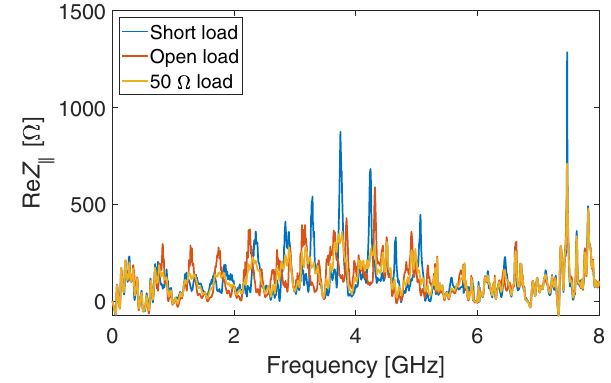
FIG. 16. The real part of the longitudinal impedance measured with different terminations on the input